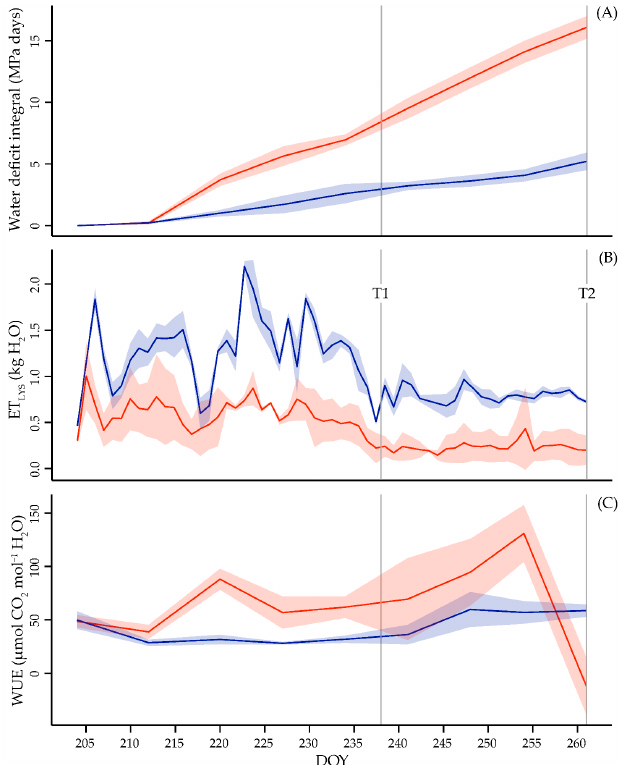
Figure 1. Split lines interpolating mean value (full color line) ± standard deviation (shaded area) of water deficit integral (panel A ), crop evapotranspiration (panel B ) and water use efficiency (panel C ), measured in Merlot vines under well-watered (WW—blue line) and water stress (WS—red line) conditions. Data are referred to the whole experimental period.